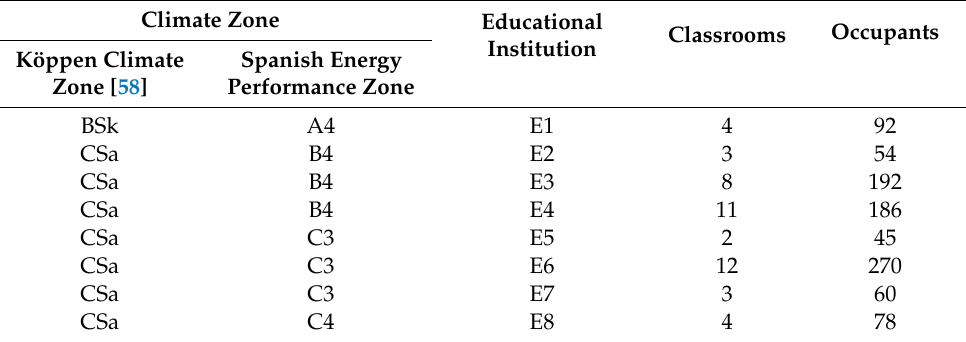
Table 1. Study samples by location and climate